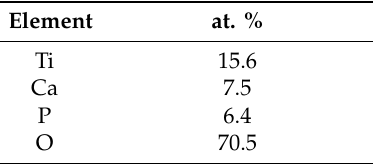
Table 3. Elemental composition of plasma electrolytic oxidation (PEO)-coatings. Element